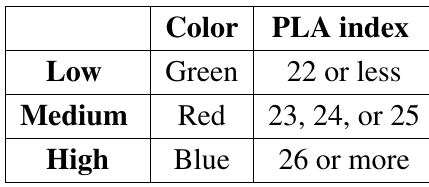
Table 1. Three classes of